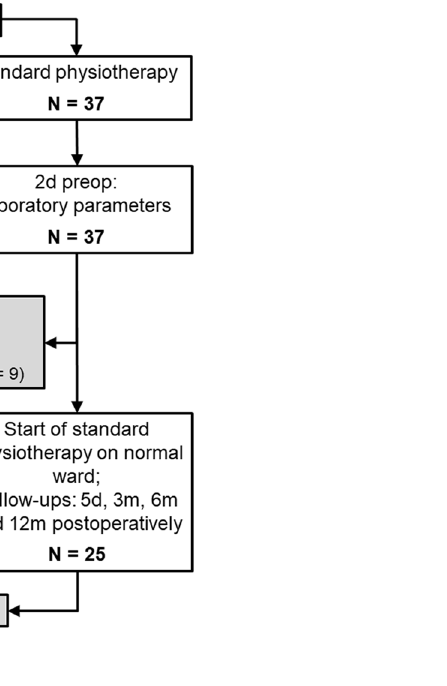
Figure 1. Study flow